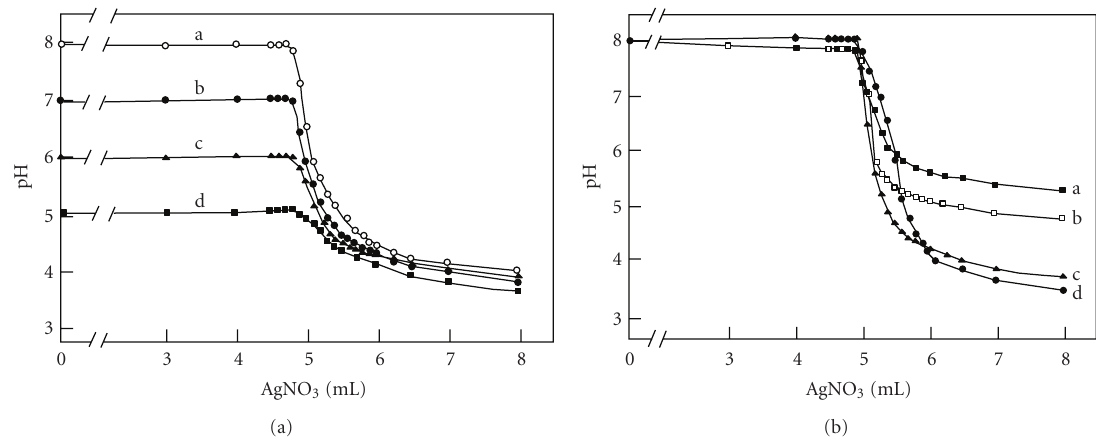
Figure 1: (a) Titration curves for 25.0mL of 0.10M NaCl with 0.50M AgNO 3 in the presence of 1.3mM phosphate at various starting pH values: (a) 7.9, (b) 7.0, (c) 6.0, and (d) 5.1. (b) Titration curves for 25.0mL of 0.10M NaCl with 0.50M AgNO 3 in the presence of various phosphate concentrations: (a) 0.05, (b) 0.20, (c) 2.0, and (d)